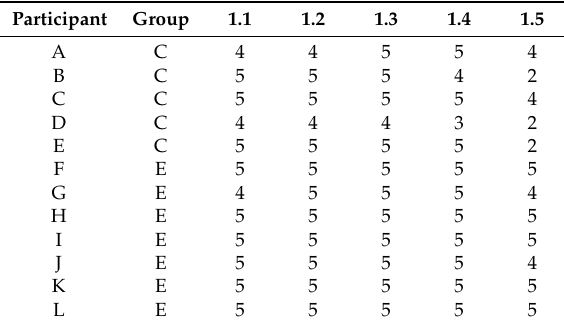
Table A8. Interim-survey section results